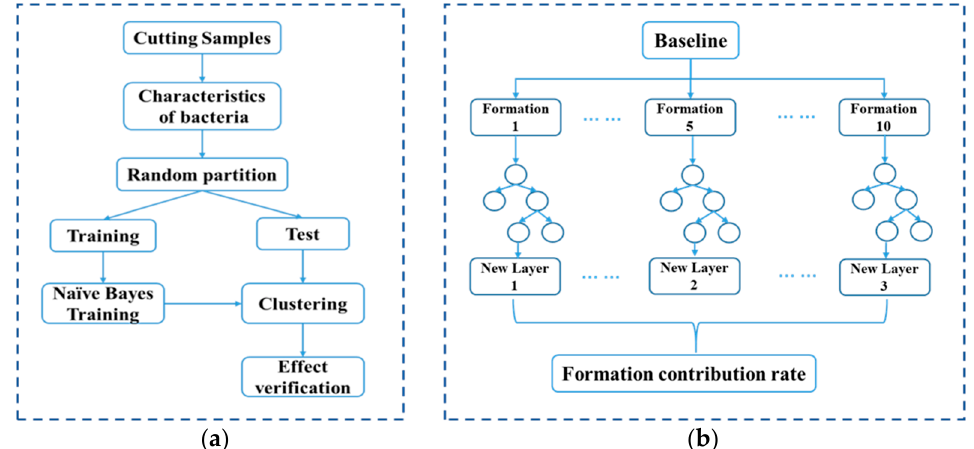
Figure 8. ( a ) Network diagram of Naïve Bayes. ( b ) Network diagram Naïve Bayes, back propagation.